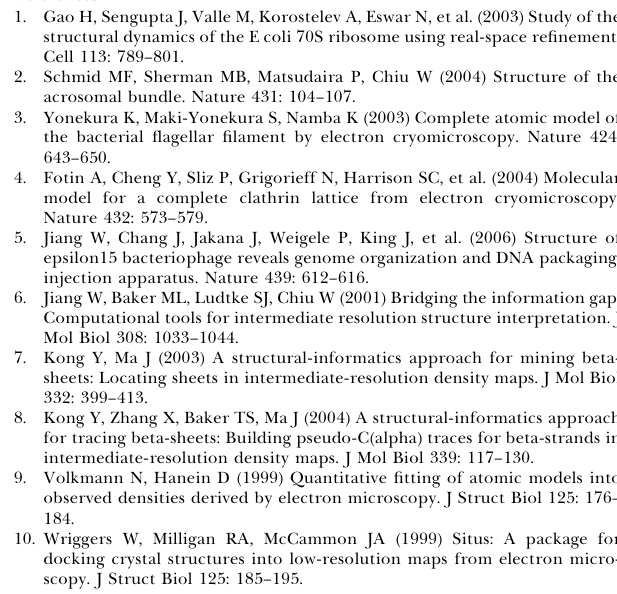
Figure S1. Modeling Hepatitis B